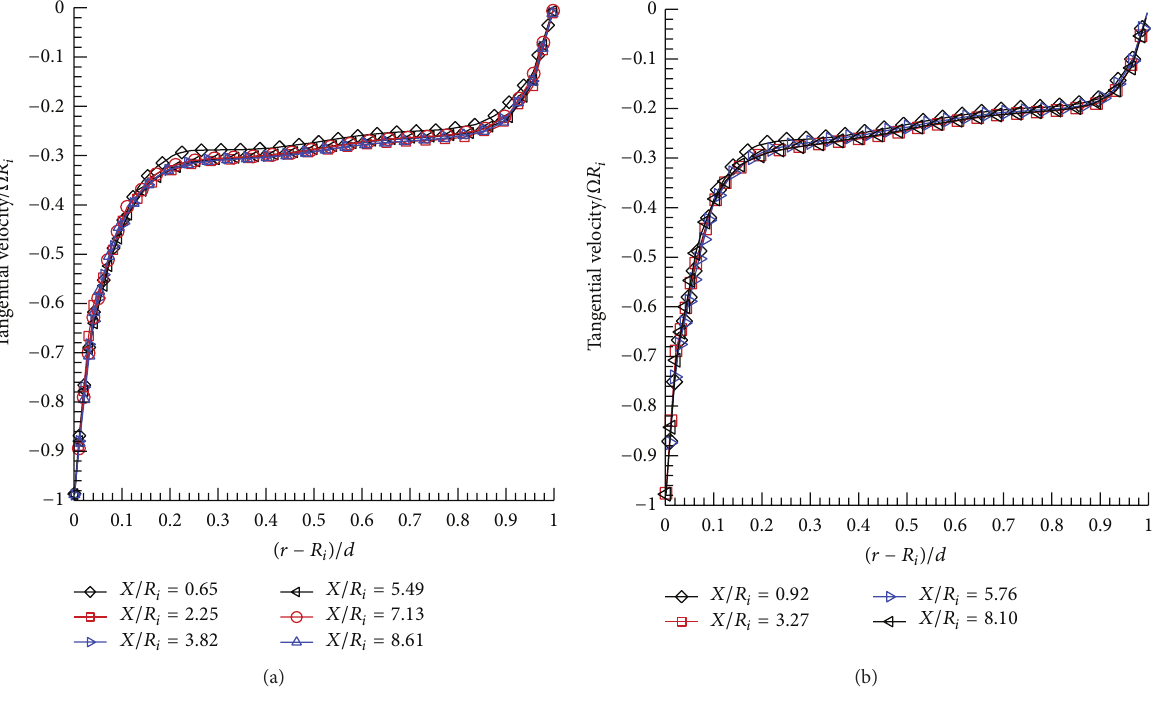
Figure 8: Normalised tangential velocity profiles through the centres of the clockwise vortices on selected axial planes at 𝜃 = −𝜋/2 for the test cases (a) Γ = 11.36 and (b) Γ = 7.81 .